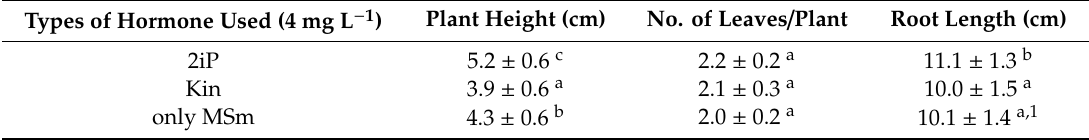
Table 2. Biometrical measurements in rhubarb plants one month after acclimatization.